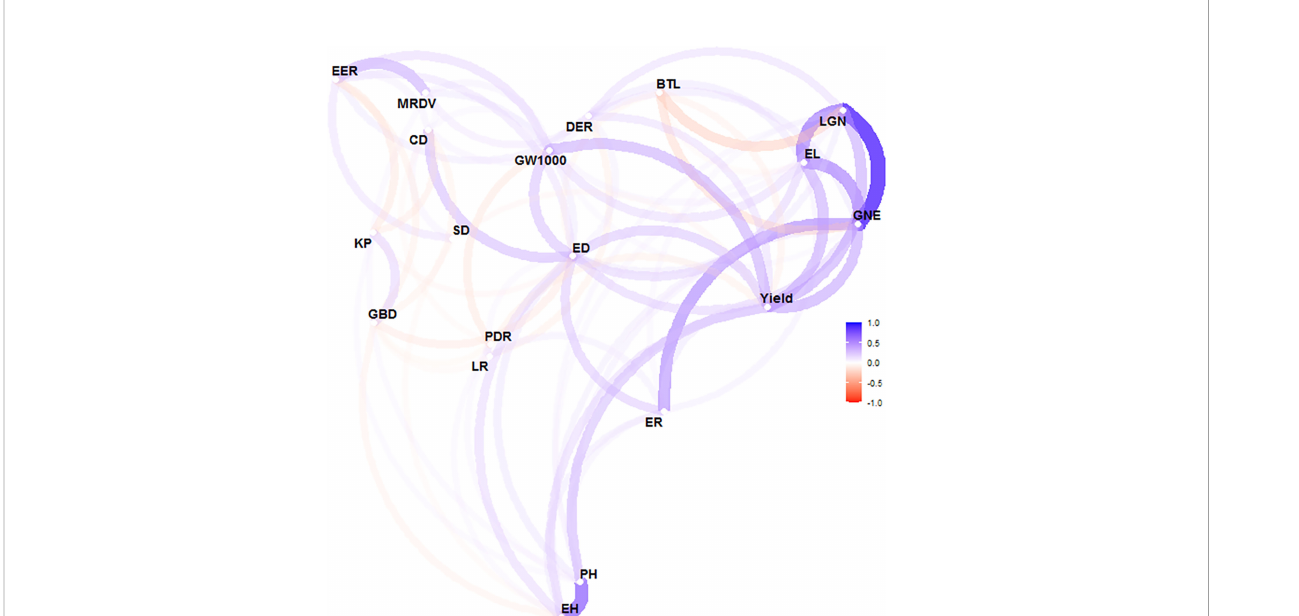
FIGURE 5 Correlation analysis of agronomic characters and yield of maize. The correlation was conducted by using the 'corrr' package in R software. The closer variables represent that these two variables are highly linearly correlated, while the opposite is the case for widely spaced variables. The line color represents the direction of the correlation. The blue line is positive correlation and the red line is negative correlation. The line shading and thickness represent the strength of the relationship. The minimum correlation coeffcient required to display a line between variables is 0.1. PH, plant height, cm; EH, ear height, cm; SD, stem diameter, cm; DER, Double ear rate, %; EER, empty ear rate, %; LR, lodging rate, %; PDR. Pour the discount rate, %; MRDV, maize rough dwarf virus, %; EL, ear length, cm; ER, ear rows; LGN, line grain number; GNE, grain number per ear: ED, ear diameter, cm; CD, cob diameter, cm; BIL, bald tip long, cm; KP, kernel percentage. %; GW1000, 1000 grains weight, g; GBD, grain bulk density, g L -1 .